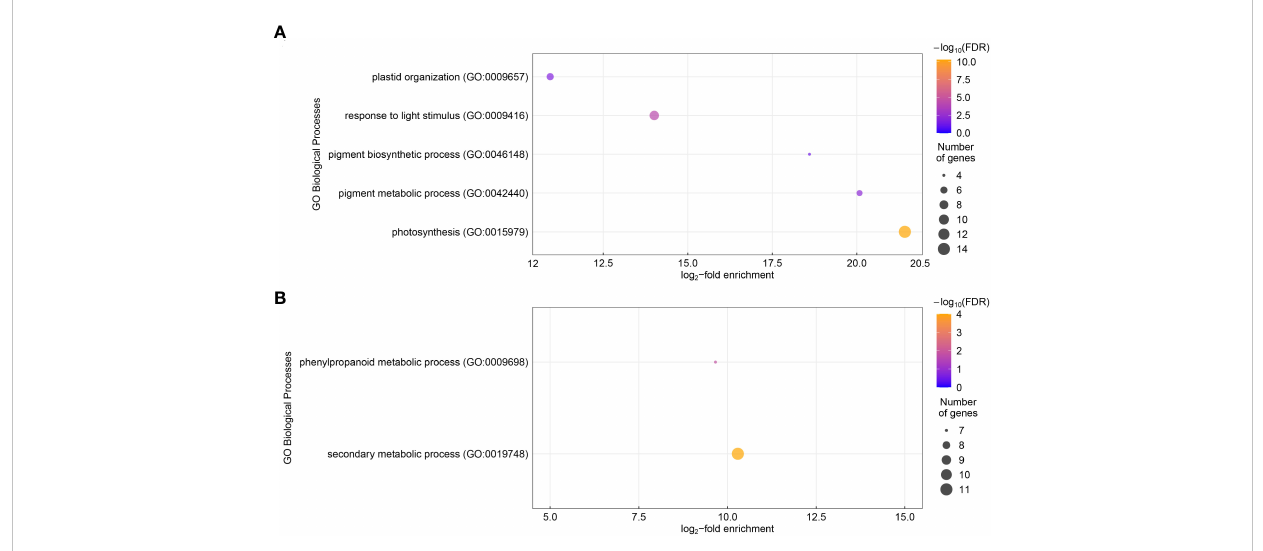
FIGURE 1 Gene Ontology (GO) biological processes enrichment of the differentially expressed genes (DEGs) for lettuce plants grown in chitin-amended soil in comparison to non-treated control plants. The log 2 -fold enrichment of GO biological processes are displayed for the upregulated genes (A) and the downregulated genes (B) in chitin-treated lettuce plants. The color of the dots shows the -log 10 of the false detection rate (FDR). The dot size is proportional to the gene number for each GO